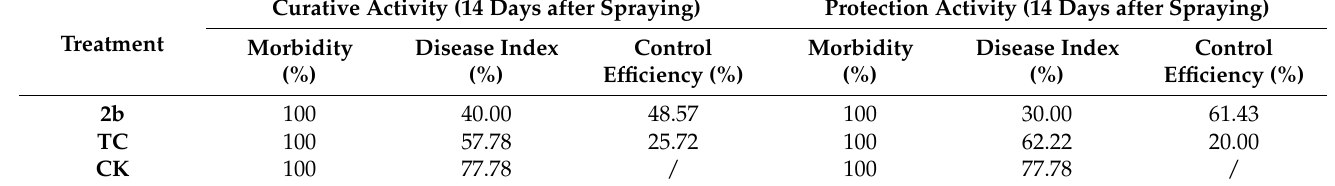
Table 3. Compound 2b and TC at 200 µ g mL − 1 in vivo demonstrated both curative and protective activities against rice bacterial leaf blight under greenhouse